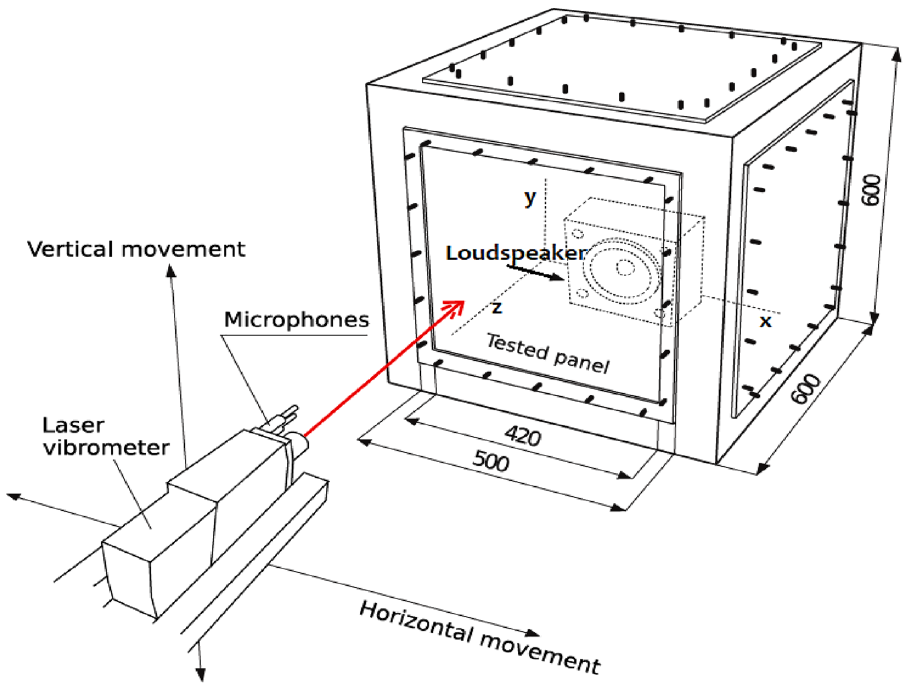
Figure 8. Illustrative diagram of the experimental set-up for acoustic radiation